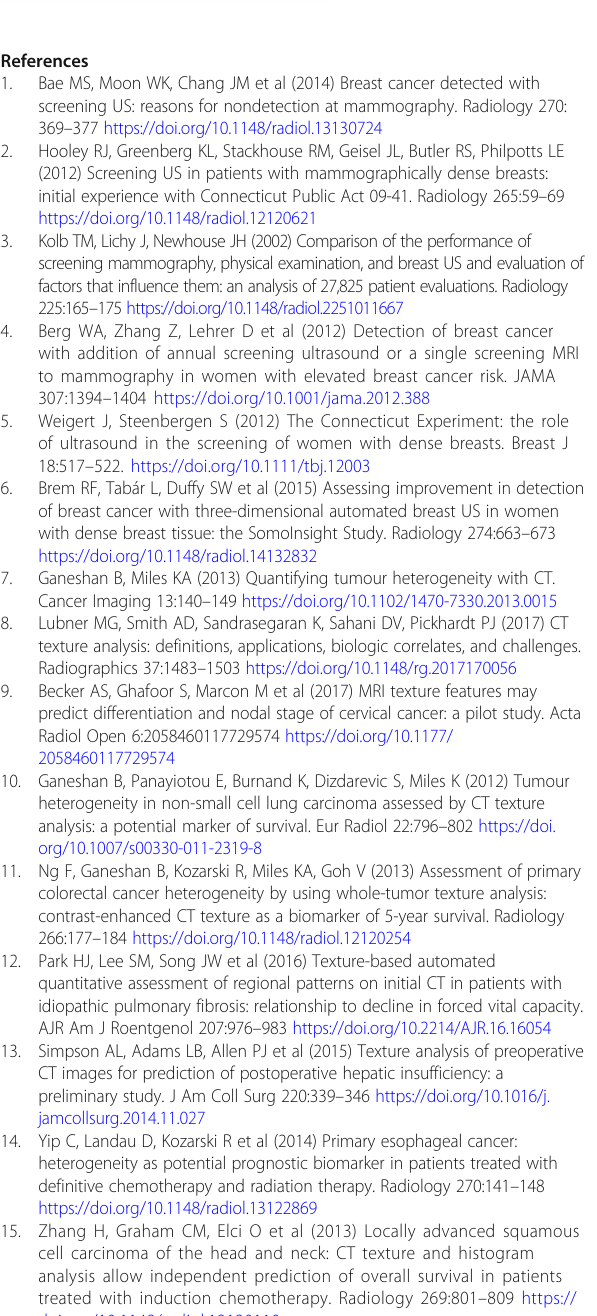
common biological properties. Figure S2. Heatmaps depicting the optimal hyperparameters for the full feature (A, B) and the reduced feature training datasets (C, D). The hyperparameter tuning was implemented via nested grid search on the SVM classifier by specifying the parameter for gamma and (C) in a logarithmic scale from 0.00001 to 0.001 and 1 to 1000, respectively. (DOCX 4241